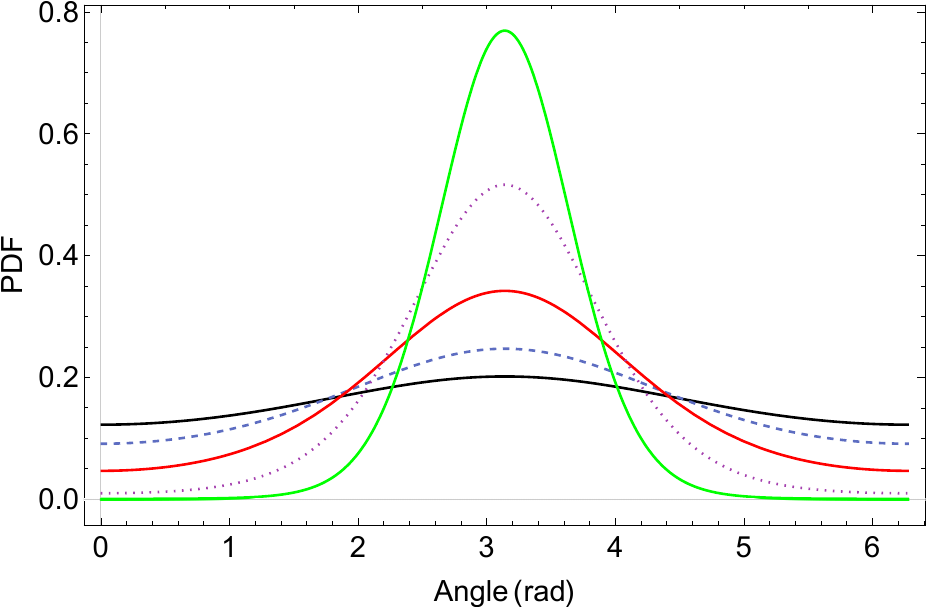
Figure 2. Probability density function (PDF) given by Equation (2) at different ratios µ E / kT . The black line corresponds to µ E / kT = 0.25, the dashed line corresponds to µ E / kT = 0.5, the red line corresponds to µ E / kT = 1, the dotted line corresponds to µ E / kT = 2, and the green line represents the case µ E / kT =